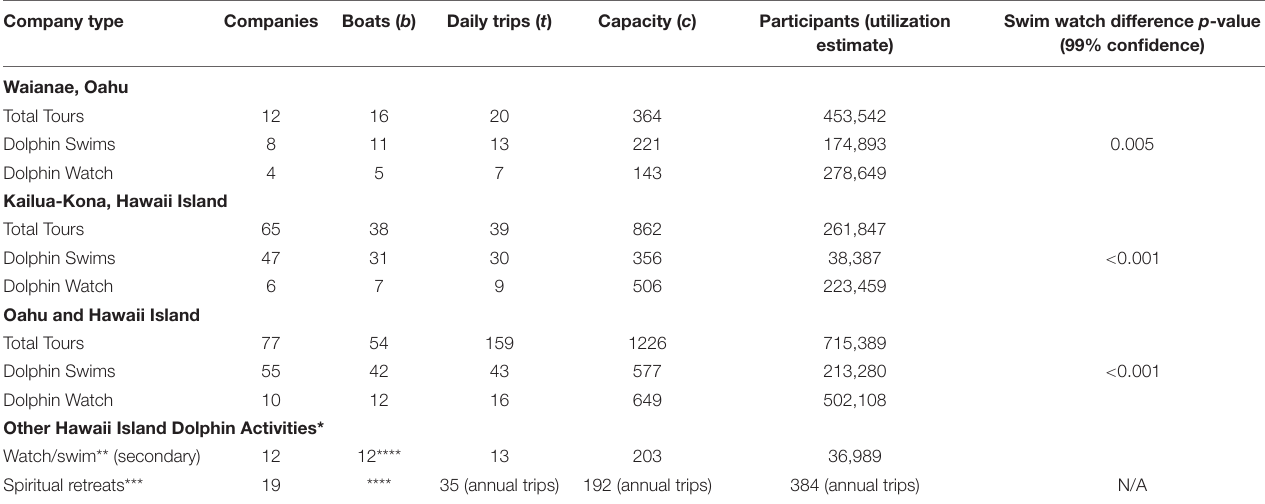
TABLE 2 | Commercial dolphin tour and dolphin-swim utilization rate estimates. Company